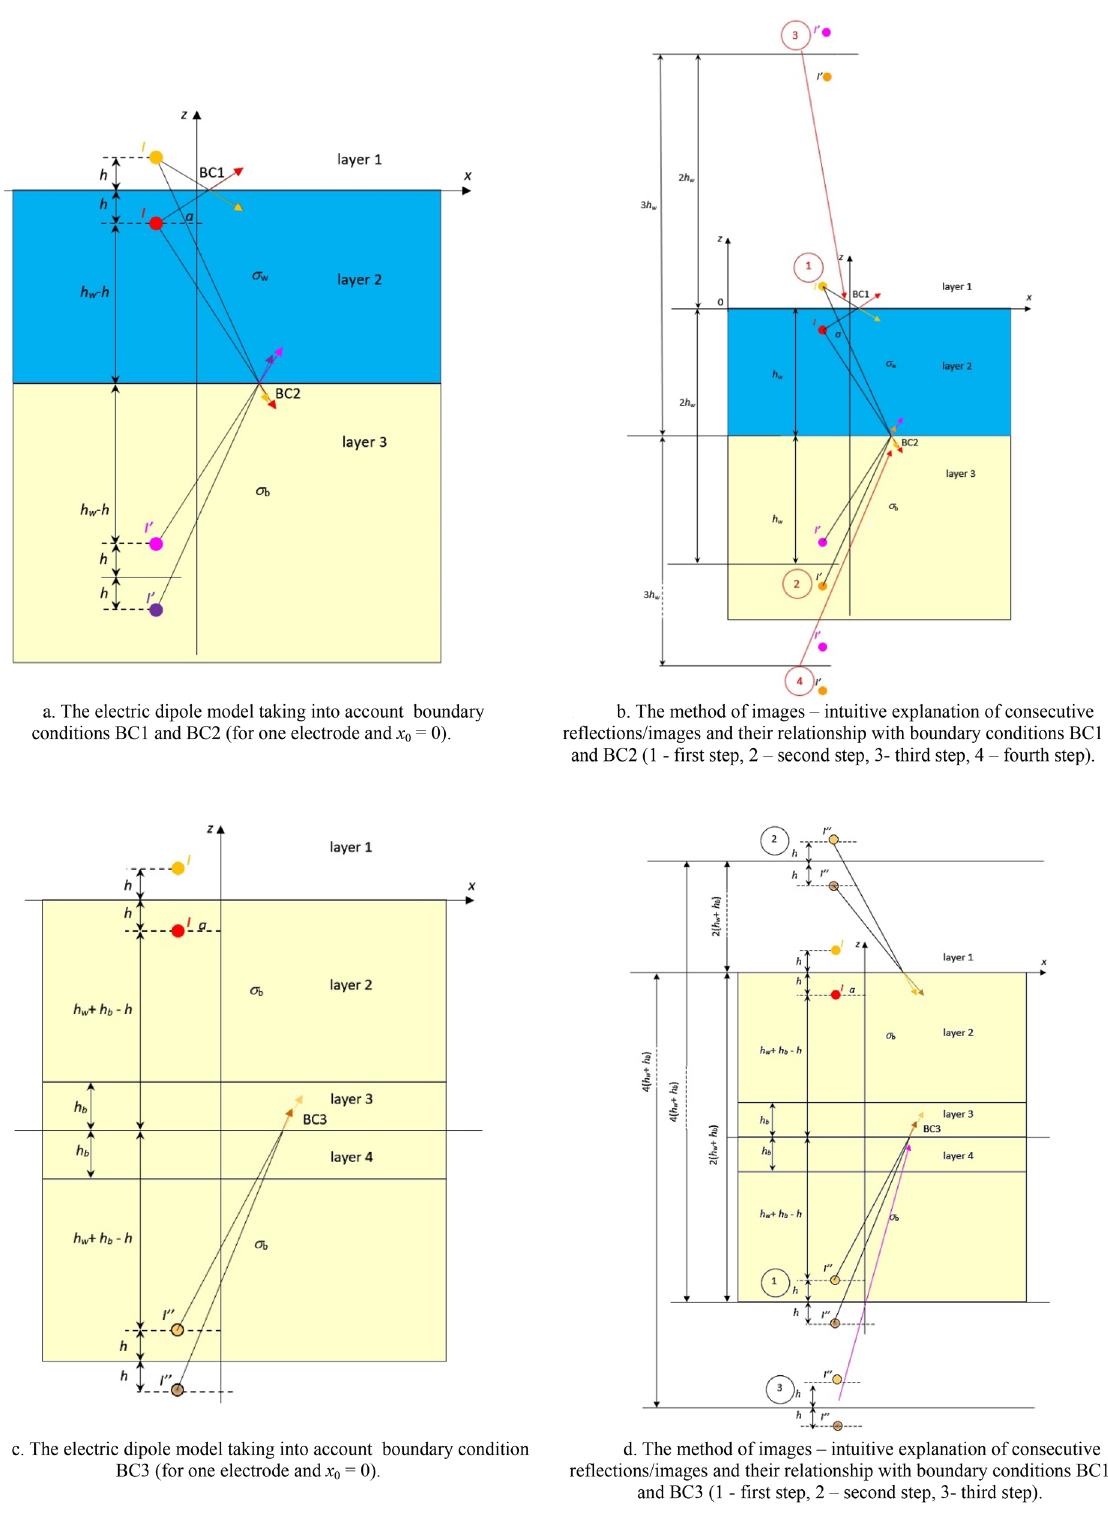
Figure 4. ( a ) The electric dipole model taking into account boundary conditions BC1 and BC2 (for one electrode and x 0 = 0). ( b ) The method of images—intuitive explanation of consecutive reflections/images and their relationship with boundary conditions BC1 and BC2 (1—first step, 2—second step, 3—third step, 4— fourth step). ( c ) The electric dipole model taking into account boundary condition BC3 (for one electrode and x 0 = 0). ( d ) The method of images—intuitive explanation of consecutive reflections/images and their relationship with boundary conditions BC1 and BC3 (1—first step, 2—second step, 3—third